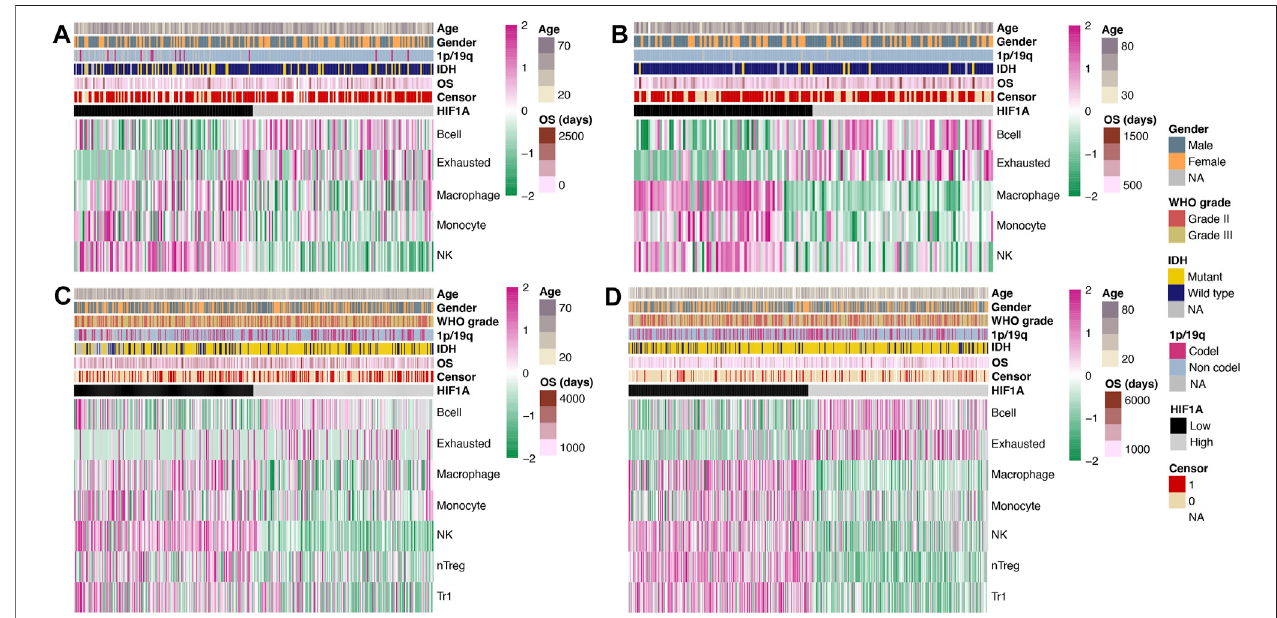
FIGURE 2 | Heatmap of the abundance of immune cells under high- and low-HIF1A-expression levels: (A) Data of GBM from the CGGA dataset, (B) data of GBM from the TCGA dataset, (C) data of lower-grade glioma from the CGGA dataset, and (D) data of lower-grade glioma from the TCGA dataset.